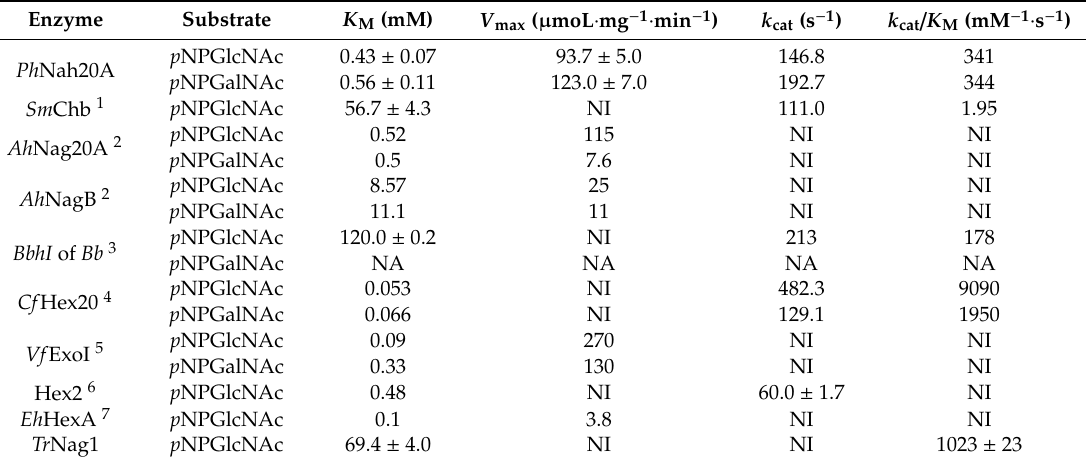
Table 1. Kinetic parameters of Ph Nah20A and β -NAHAs from the literature on p NPGlcNAc